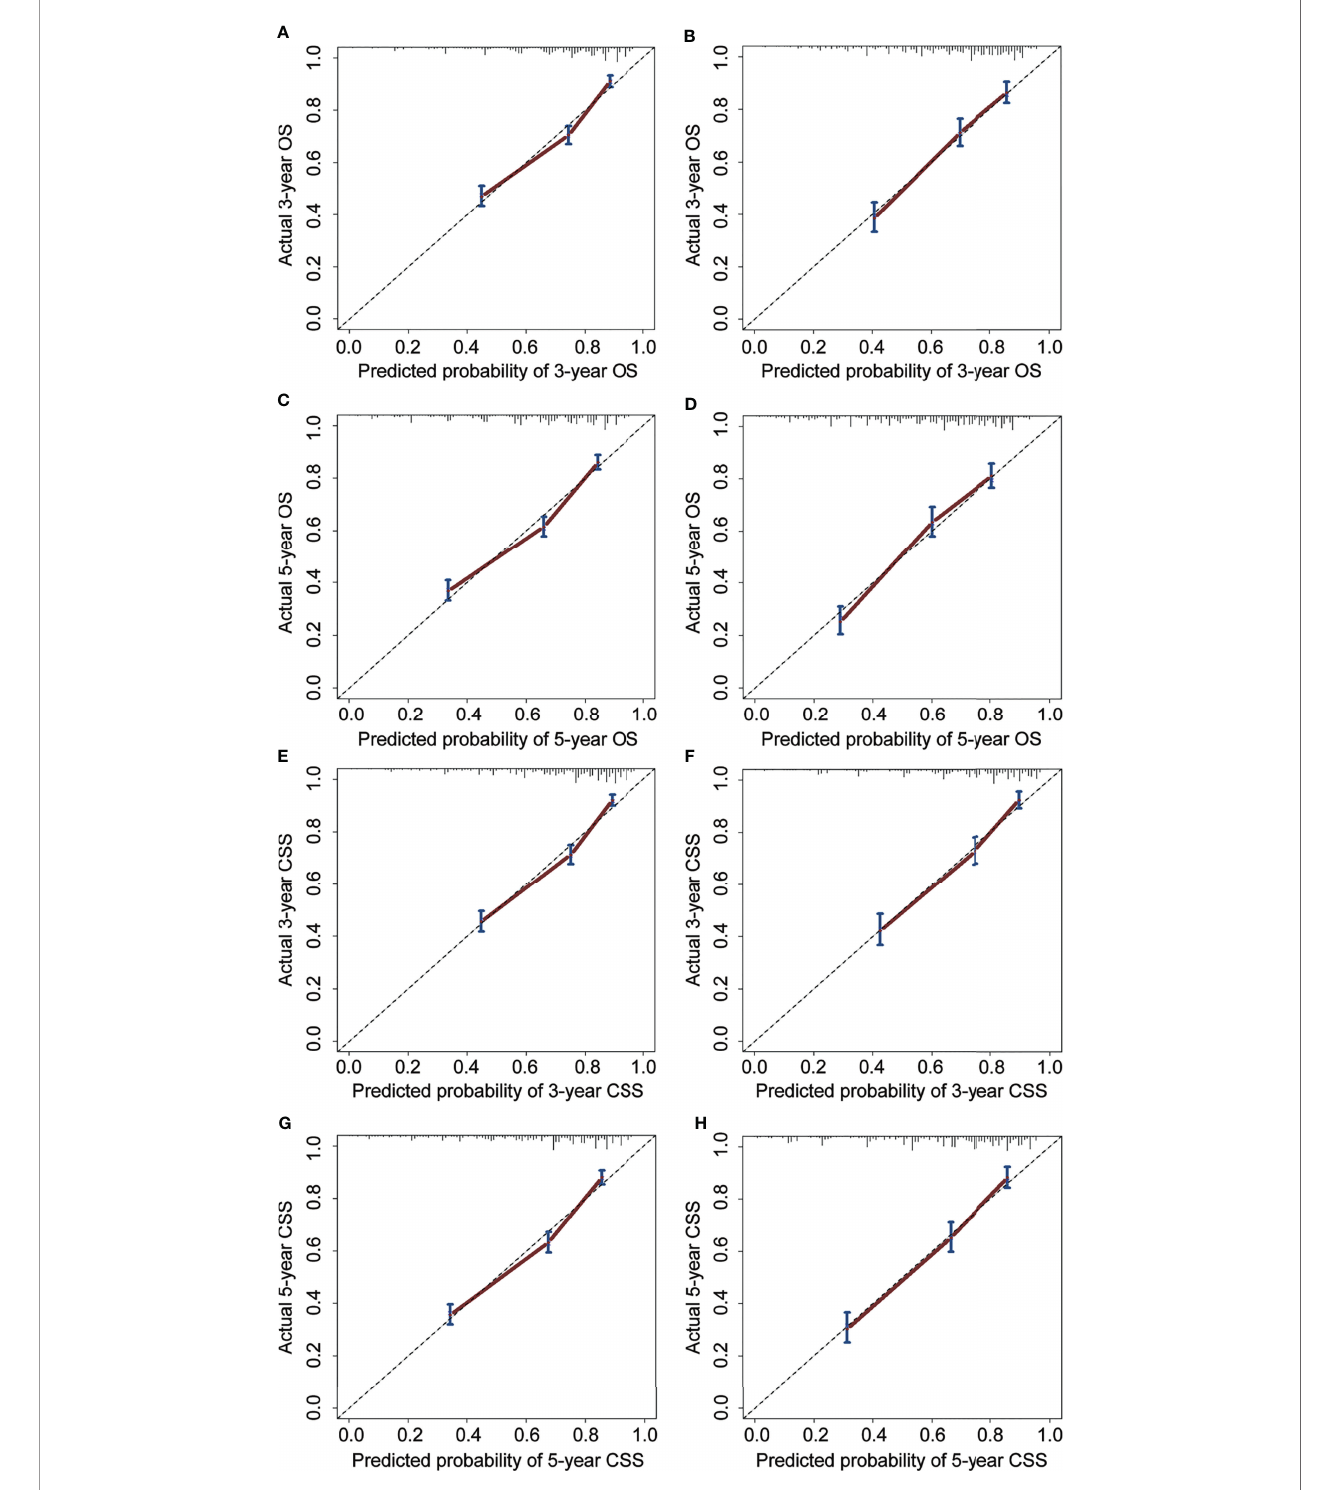
FIGURE 4 | Calibration curves for 3- and 5-year OS and CSS of the prognostic nomograms. Calibration curves for 3- and 5-year OS prediction in the training cohort (A, C) and the validation cohort (B, D) . Calibration curves for 3- and 5-year CSS prediction in the training cohort (E, G) and the validation cohort (F, H) . OS, overall survival; CSS, cancer-speci fi c